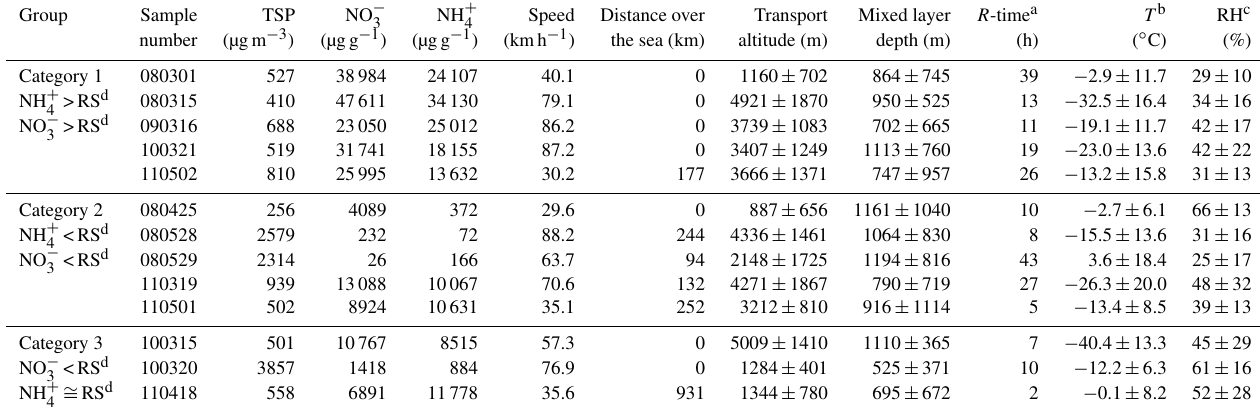
Table 7. Concentrations of TSP, NO − and NH + ; transport speed; transport distance over the sea; transport distance; air temperature; RH; 3 4 average mixed layer during transport and transport time in polluted regions for atmospheric aerosol samples on dust days.